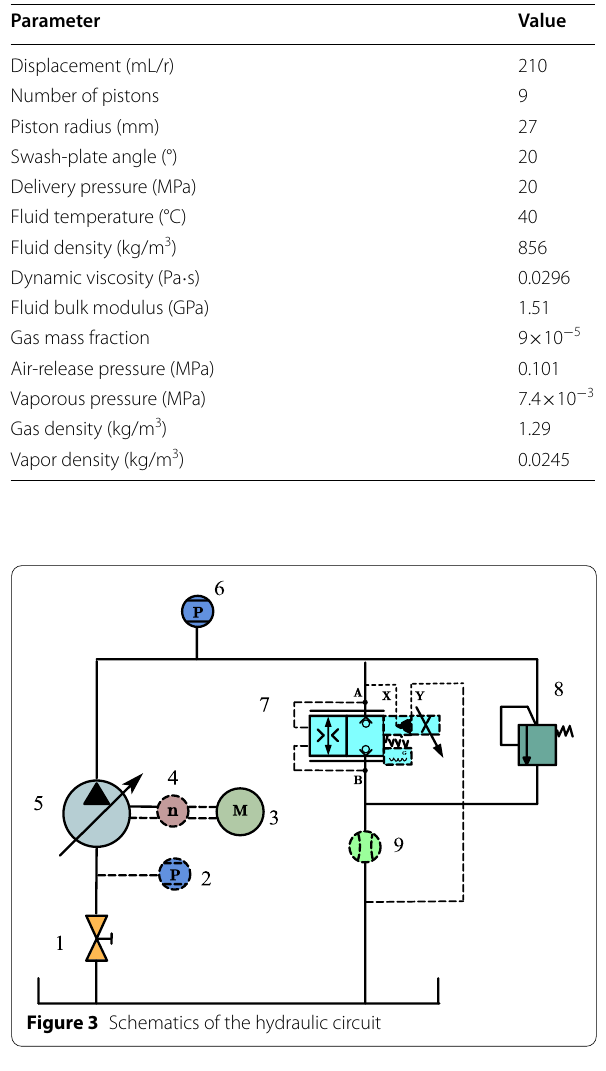
Table 1 Parameter setting in the CFD model